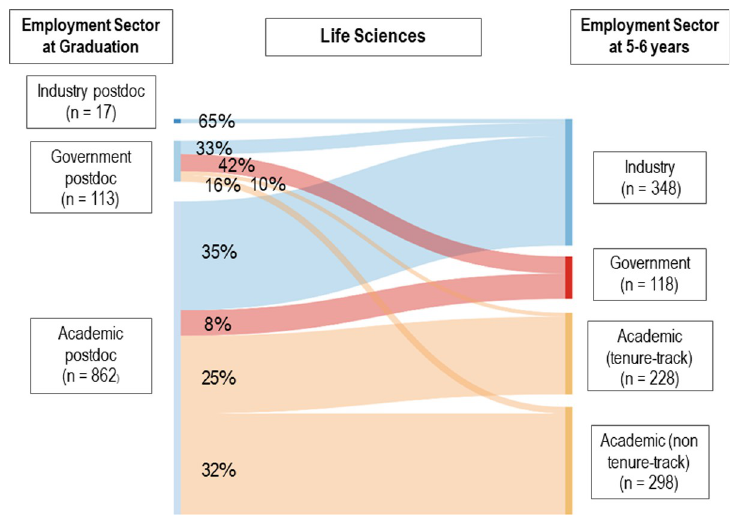
Fig 2. Sankey diagram of life sciences postdoc movement to permanent